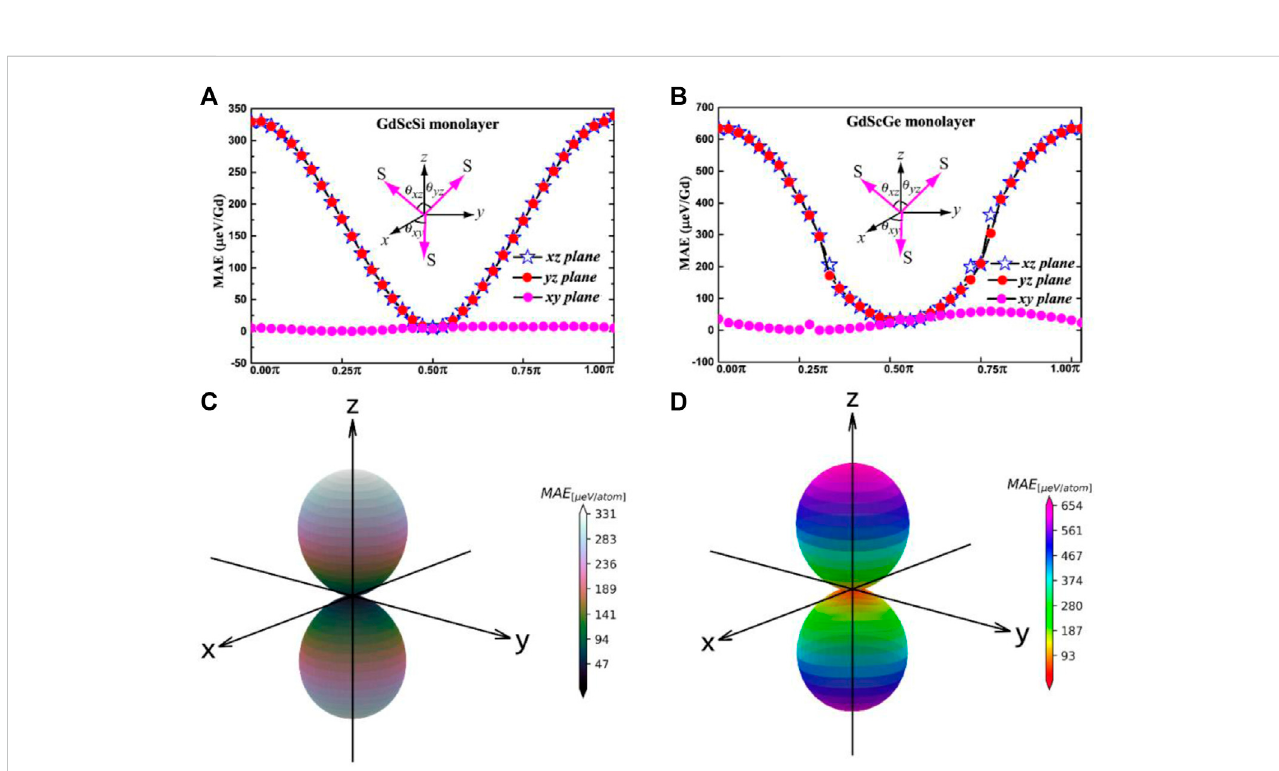
FIGURE 5 Angular dependence of the magnetic anisotropic energy (MAE) with the direction of magnetization lying on three different planes and the whole space for the GdScSi monolayer (A, B) and the GdScGe (C, D) monolayer.